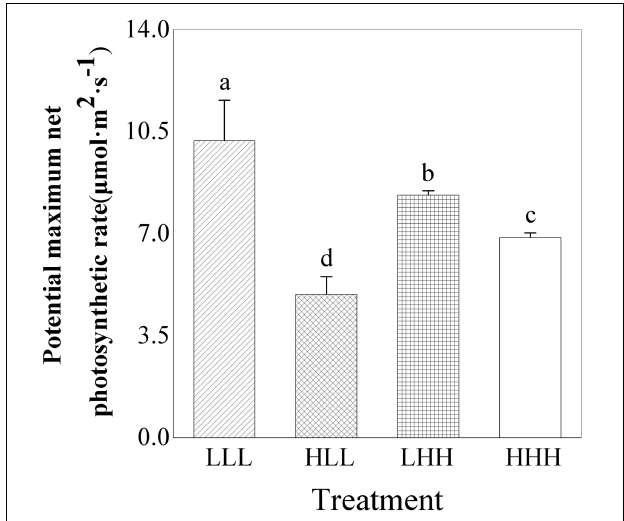
FIGURE 4 | Effects of transgenerational plasticity on potential maximum net photosynthetic rate of offspring ramets (F 2 generations). The same lower case letters are not significantly different at the P = 0.05 level. Values are means ± s.e. (standard errors), n = 8. HHH: F 0 generation high light + F 1 generation high light + F 2 generation high light; HLL: F 0 generation high light + F 1 generation low light + F 2 generation low light; LHH: F 0 generation low light + F 1 generation high light + F 2 generation high light; LLL: F 0 generation low light + F 1 generation low light + F 2 generation low light.